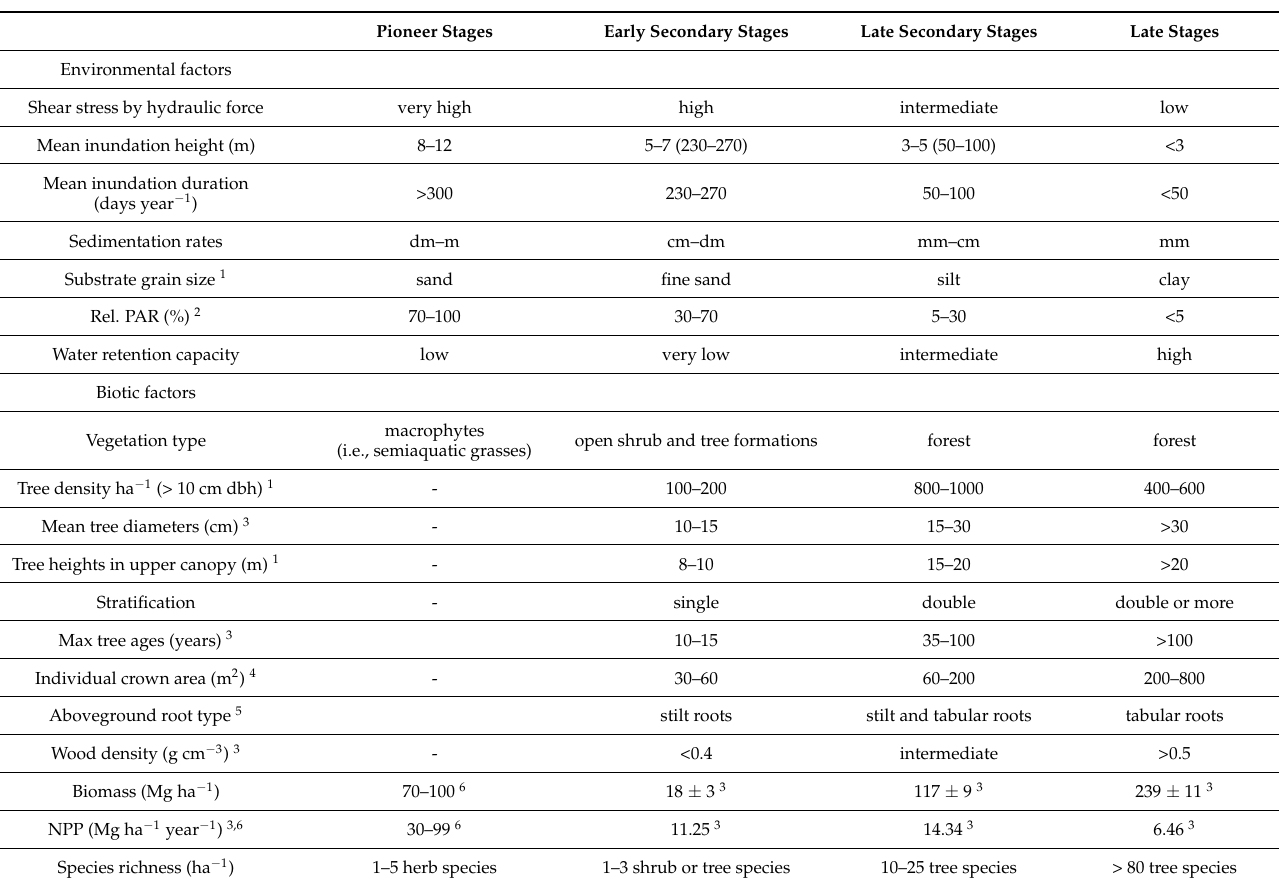
Table 5. In Amazonian v á rzea next to the main river channels, the interaction of environmental and biotic variables generates a certain predictability of vegetation type distribution based on the classification in successional stages (sensu [129]). Exceptions in the progression may occur when highly flooded forest patches are subject to relatively slow sediment deposition rates, as exemplified in the successional model provided by Wittmann et al. [42]. 1 [53], 2 [130], 3 [3], 4 [47], 5 [68], 6 [104]. Table modified from